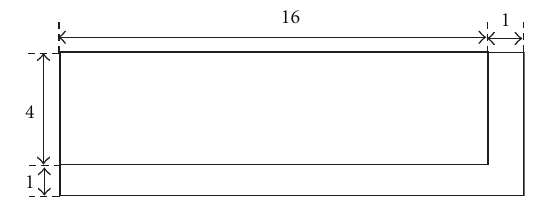
Figure 3: An example of the shared memory tiles used complete with a halo on two sides to store the extra values that are